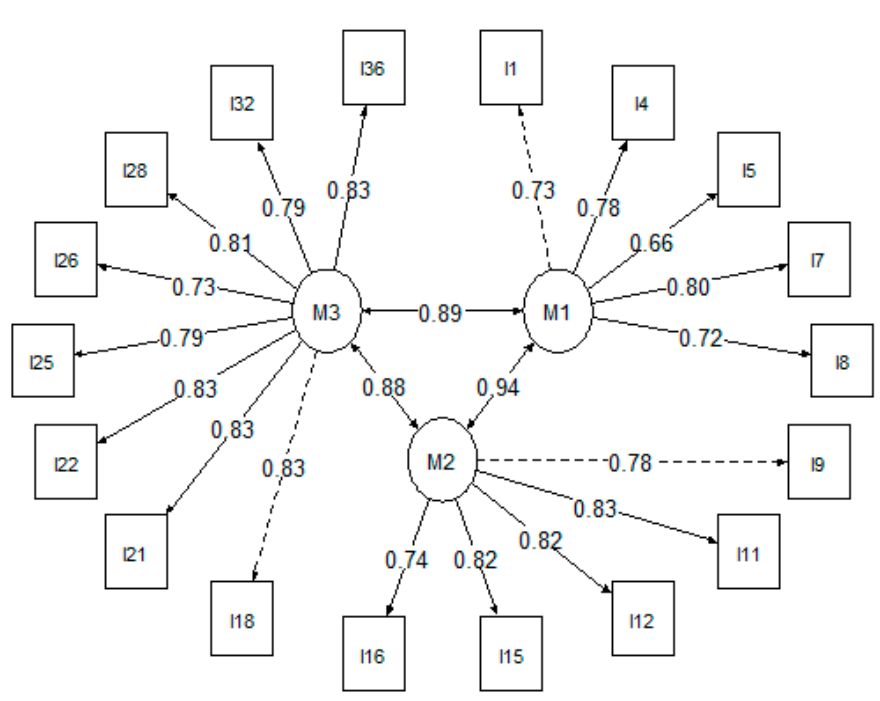
Figure 1. The final model of the CTPI-EPE. Note. M1 = Facilitating Active Construction Knowledge in Games and Skills; M2 = Facilitating Personal Relevance; M3 = Facilitating Social Cooperation; I = Item.